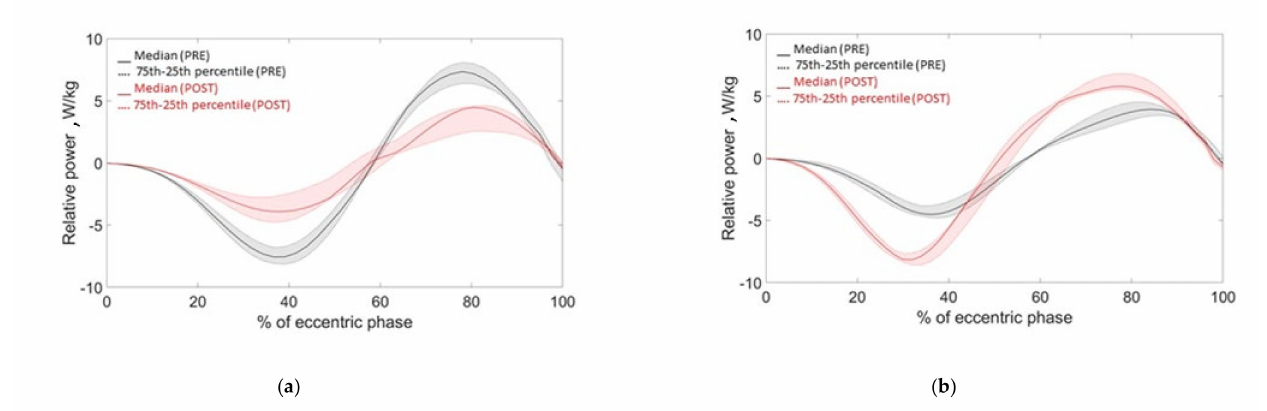
Figure 4. Power traces of a fatigued group ( a ) and Post-Activation Potentiation (PAP) group ( b )